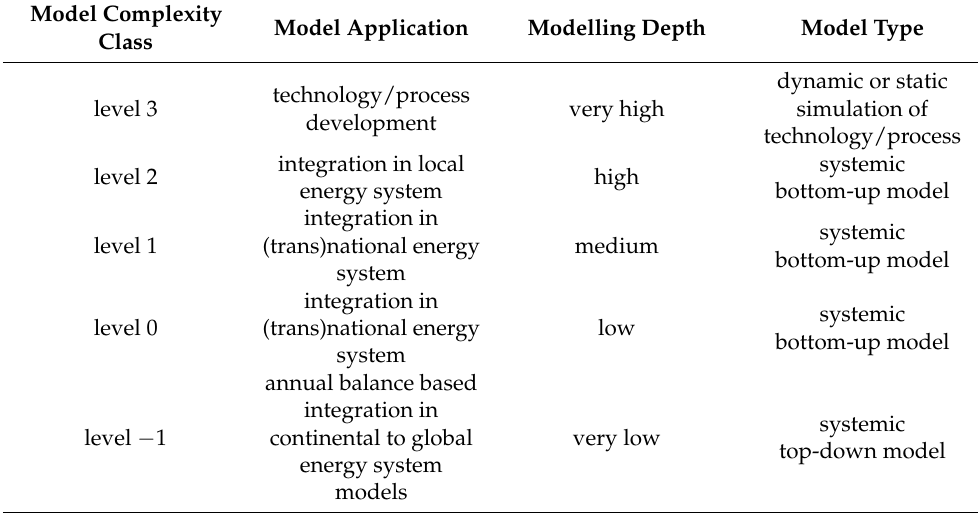
Table 1. Classification of energy storage models considering model application and modelling